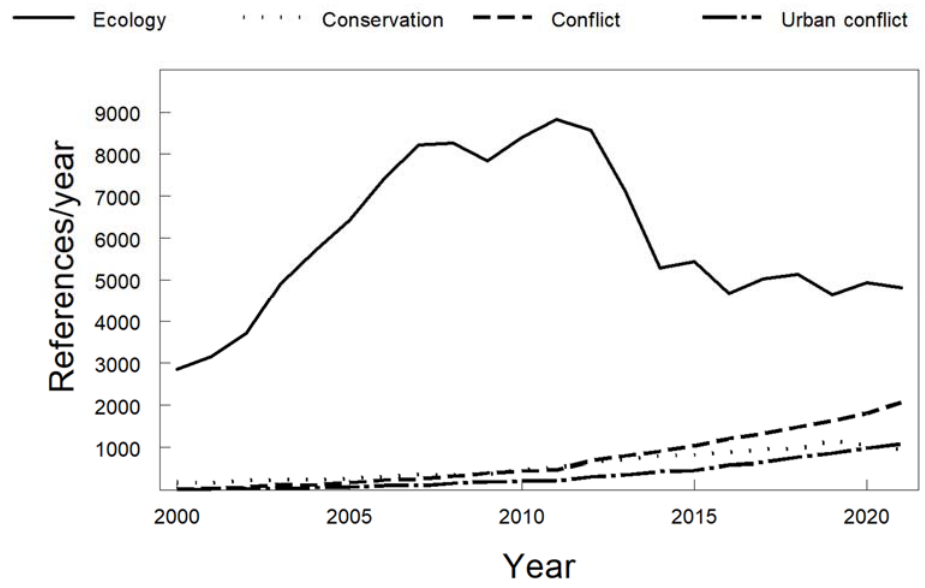
Figure 1. Trends in publications on urban ecology and conservation since 2000. Data are taken from Google Scholar searches conducted at the end of 2021. Search terms used were Ecology: “urban ecology”; Conservation: “urban conservation”; Conflict: “human-wildlife conflict”; and Urban conflict: “urban + “human-wildlife conflict””.